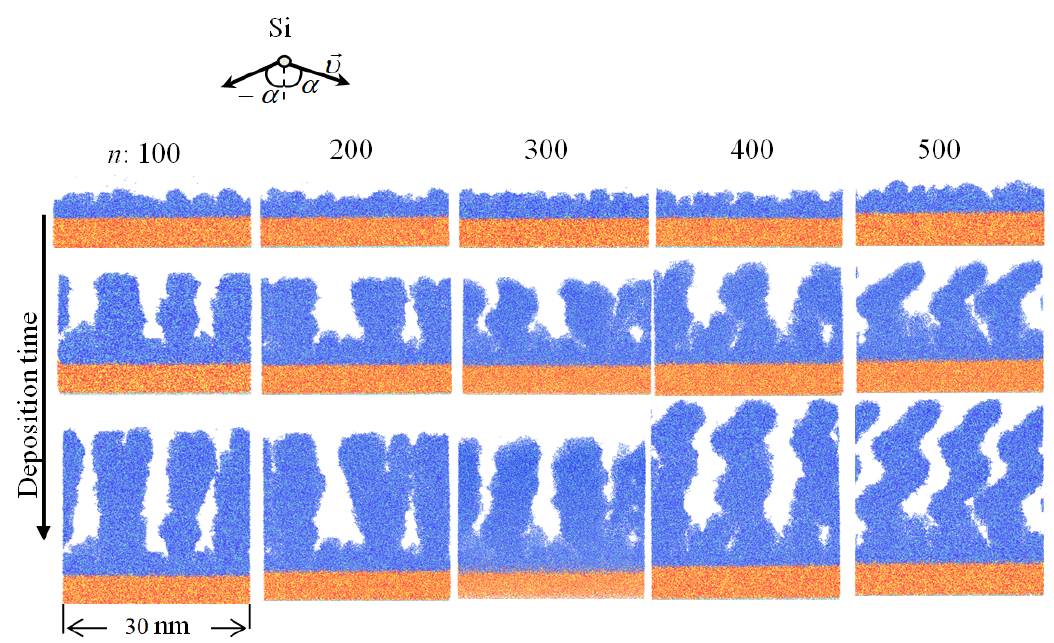
Figure 2. Atomistic structures of growing GLAD films on small substrates: side view in the X-Z plane. The deposition angle α = 80° is altered after every n injection step. Energy of the deposited Si atoms is 10 eV. Substrate atoms are painted as yellow (Si) and red (O), deposited atoms are painted as green (Si) and blue (O).